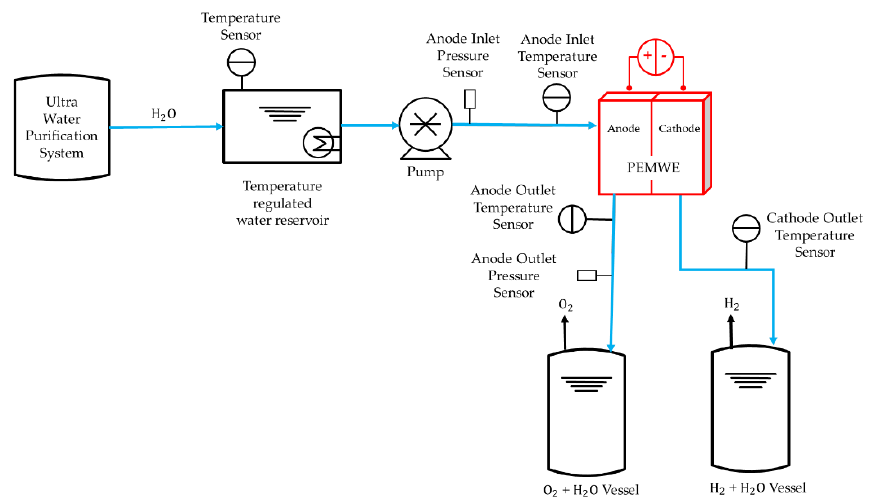
Figure 4. Schematic of the pump, reservoir, and sensors used in the PEMWE experiment procedure for validation.